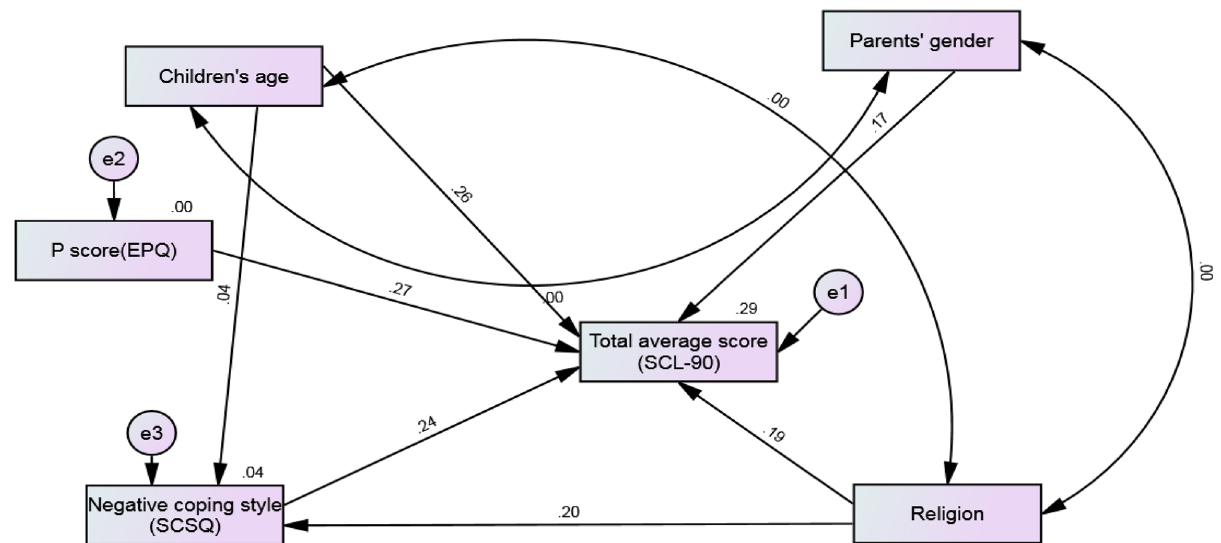
Figure 1. Path analysis diagram and final model of total average score (SCL-90).